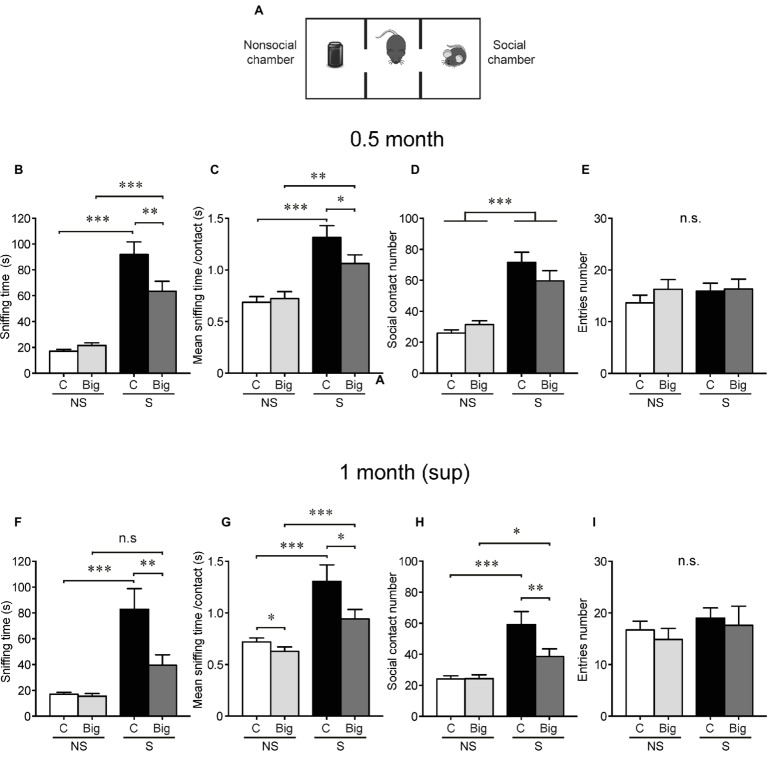
tTA/WT12 mice display early sociability deficits, which persist after transgene suppression. (A) Scheme of three-chamber social interaction apparatus, a rectangular box made of a black Plexiglass divided in three interconnected chambers. Social behavior was analyzed at 0.5 months off Dox (0.5 month mice) (B–E), and after 2 weeks of Dox transgene suppression treatment [1 month (sup)] (F–I). (B,F) The time spent sniffing the social (S; P21–P28 male mouse) or the non-social (NS; black plastic object) stimulus during a 10 min session (test phase) was recorded. (C,G) Mean sniffing time per contact. (D,H) Number of social contacts. (E,I) Total entries in each chamber. *p < 0.05, **p < 0.01, ***p < 0.001, two-way RM-ANOVA/Newman-Keuls post hoc test, except for (G), significance of main effects. n = 11, 15 for control and bigenic 0.5 month mice, respectively; n = 10, 13 for control and bigenic 1 month (sup) mice, respectively. n.s., not significant. Data represent mean ± SEM.